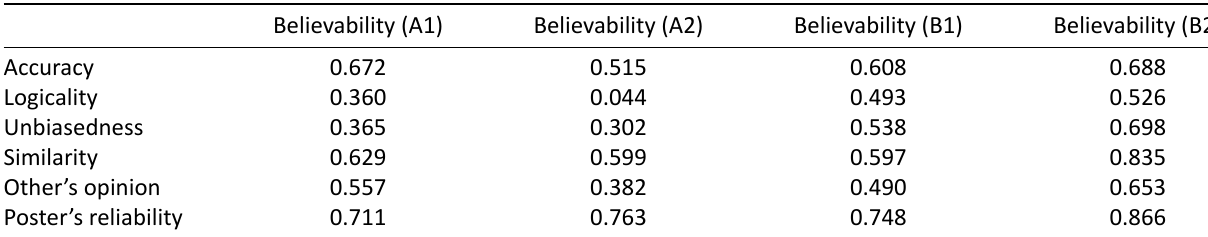
Table 6. Pearson correlation for believability.